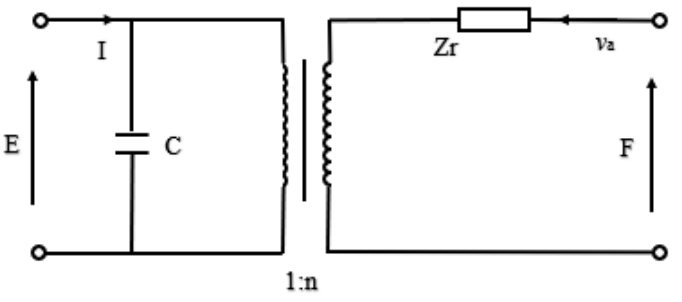
Figure 7. Electromechanical equivalent diagram of radial vibration of piezoelectric ceramic disk.